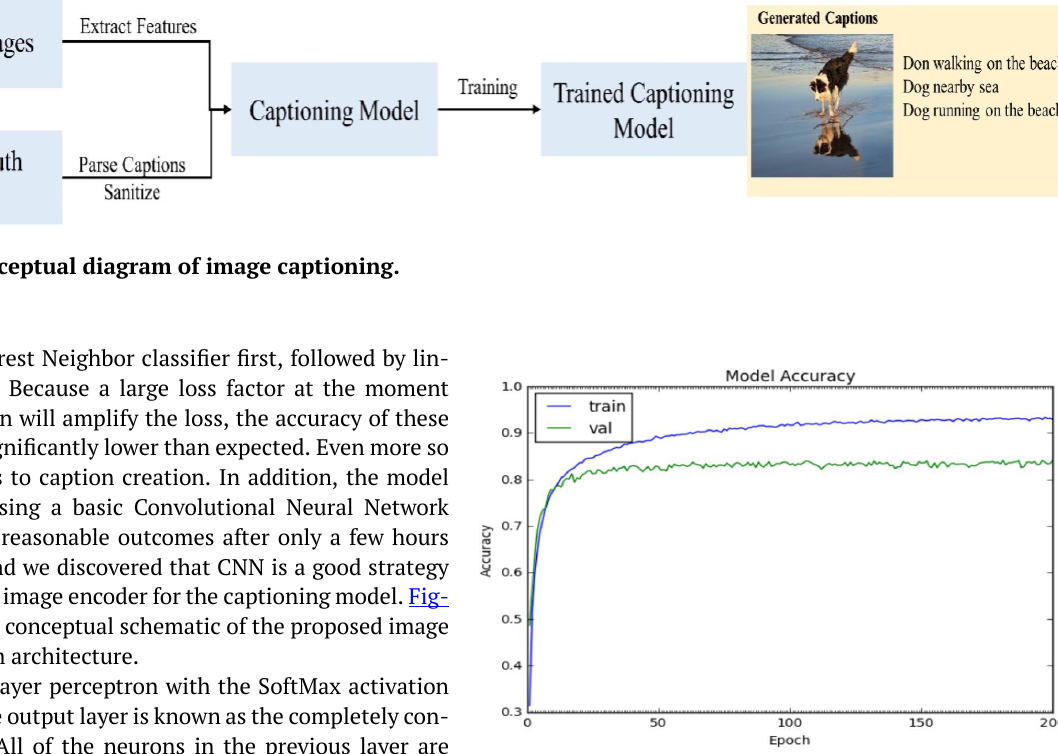
Figure 5. Accuracy and loss plot on the training and validation set.